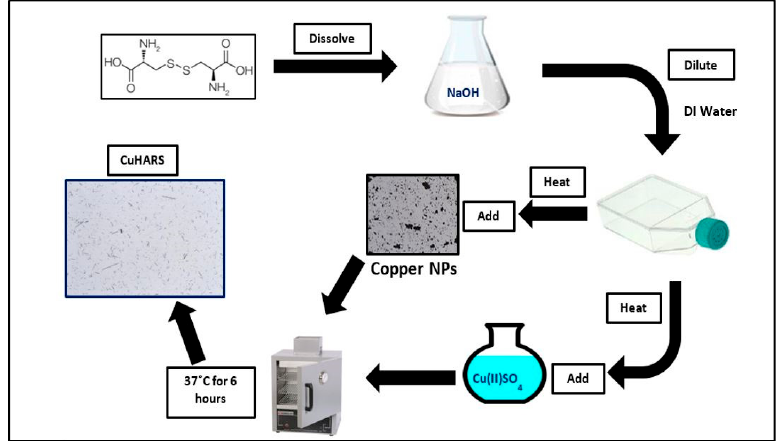
Figure 1. Schematic overview of synthesis of copper-containing high-aspect ratio structures (CuHARS) metal–organic biohybrids (MOBs). In the work presented here, synthesis was carried out only using copper sulfate (Cu(II)SO 4 ).